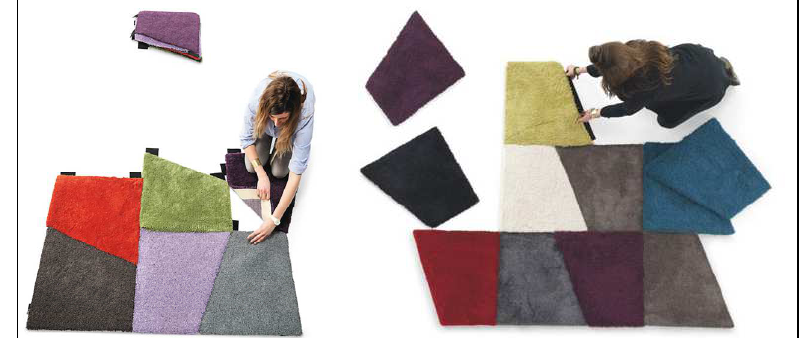
Figure 2: Slide Carpet by